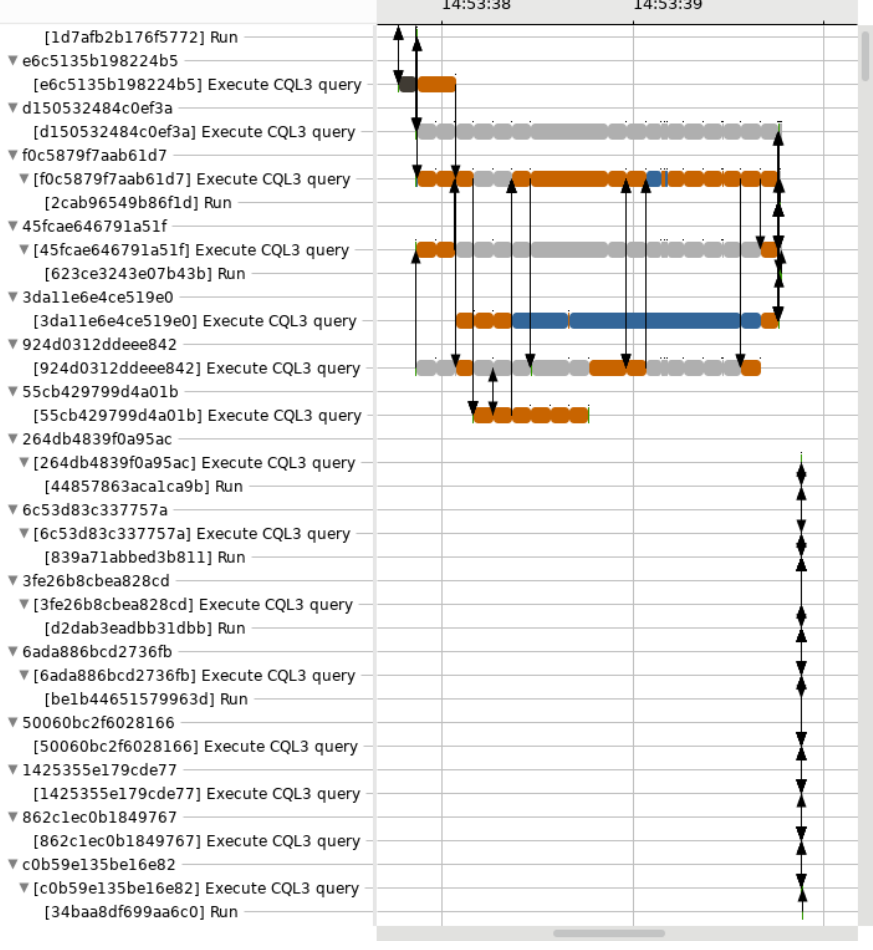
Figure 12. Use case: identifying the latency. The requests are all equivalent in the expected execution time, but the ones on the left take 2 s to process, as opposed to about 5 ms for the ones on the right. The view shows that the slow requests spend most of their time waiting on CPU or on another